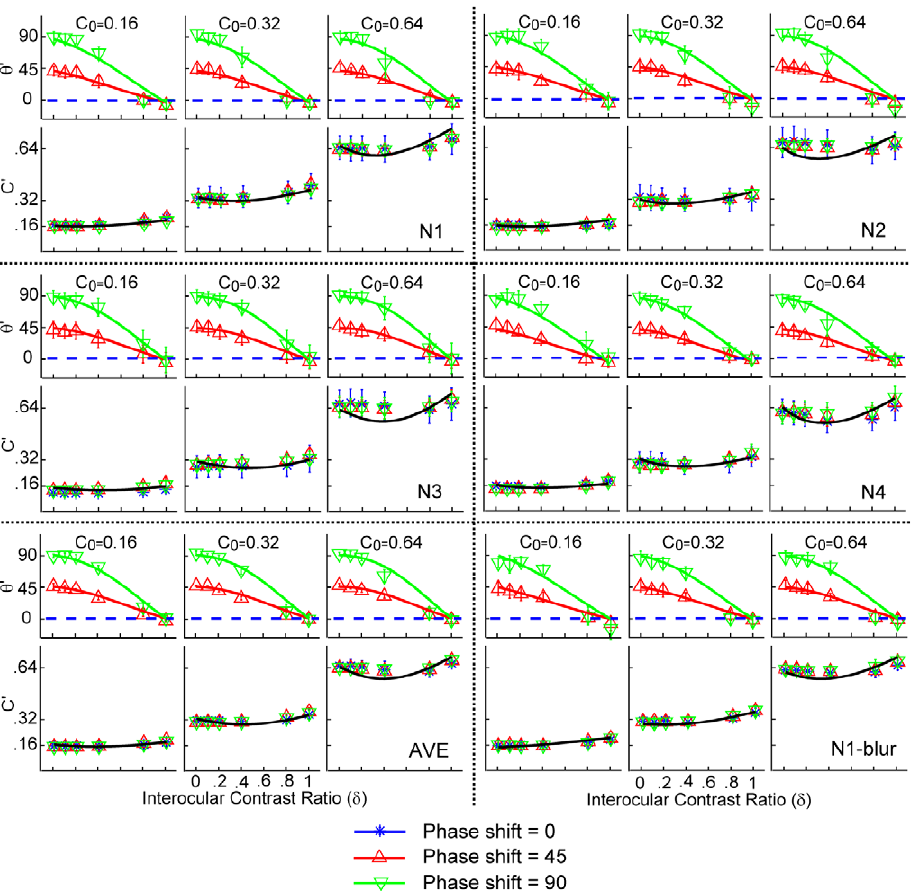
Figure 2. Perceived contrast and phase of the cyclopean images. Data from different base contrast conditions are shown in separate panels. For each observer, data from the three base contrast conditions are shown in three columns. Within each column, the upper row shows the perceived phase (in degrees) and the lower row shows the perceived contrast, both as a function of the interocular contrast ratio. Different colors denote different phase shift conditions: blue asterisk for 0 degree, red upward-pointing triangle for 45 degrees, and green downward-pointing triangle for 90 degrees. Subjects only performed the phase matching task in the 45 and 90 degree conditions. The blue dashed line indicates expected output with zero phase difference. Error bars represent standard deviations.